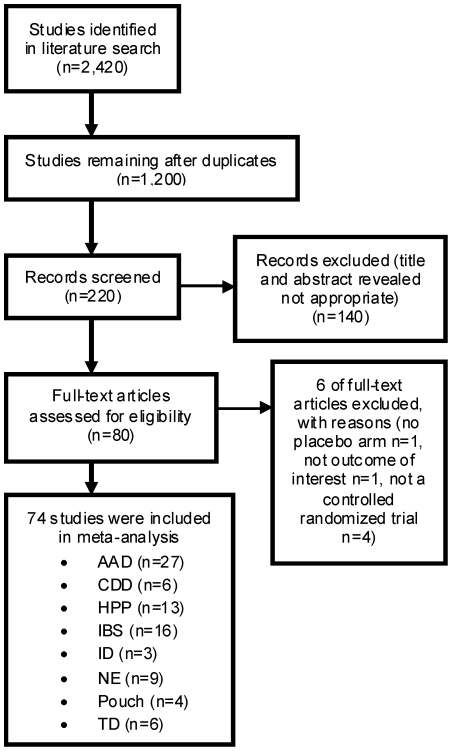
PRISMA (Preferred Reporting Items for Systematic reviews and Meta-Analyses) flow diagram showing an overview of the study selection process.